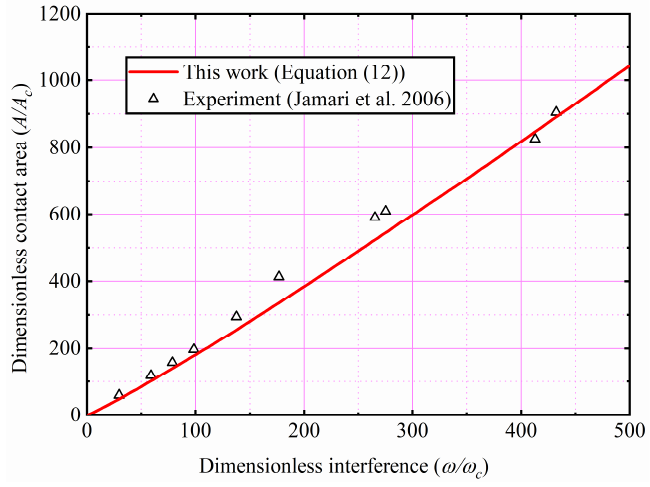
Figure 14. Comparison with experimental result for the copper [27].